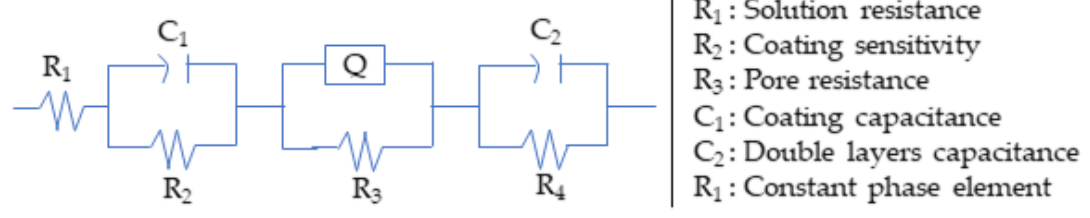
Figure 11. Circuit for Zn–Ni alloy and Zn–Ni–WC composite electrodeposits. Table 3. Electrochemical kinetic parameters of the coatings extrapolated from EIS.